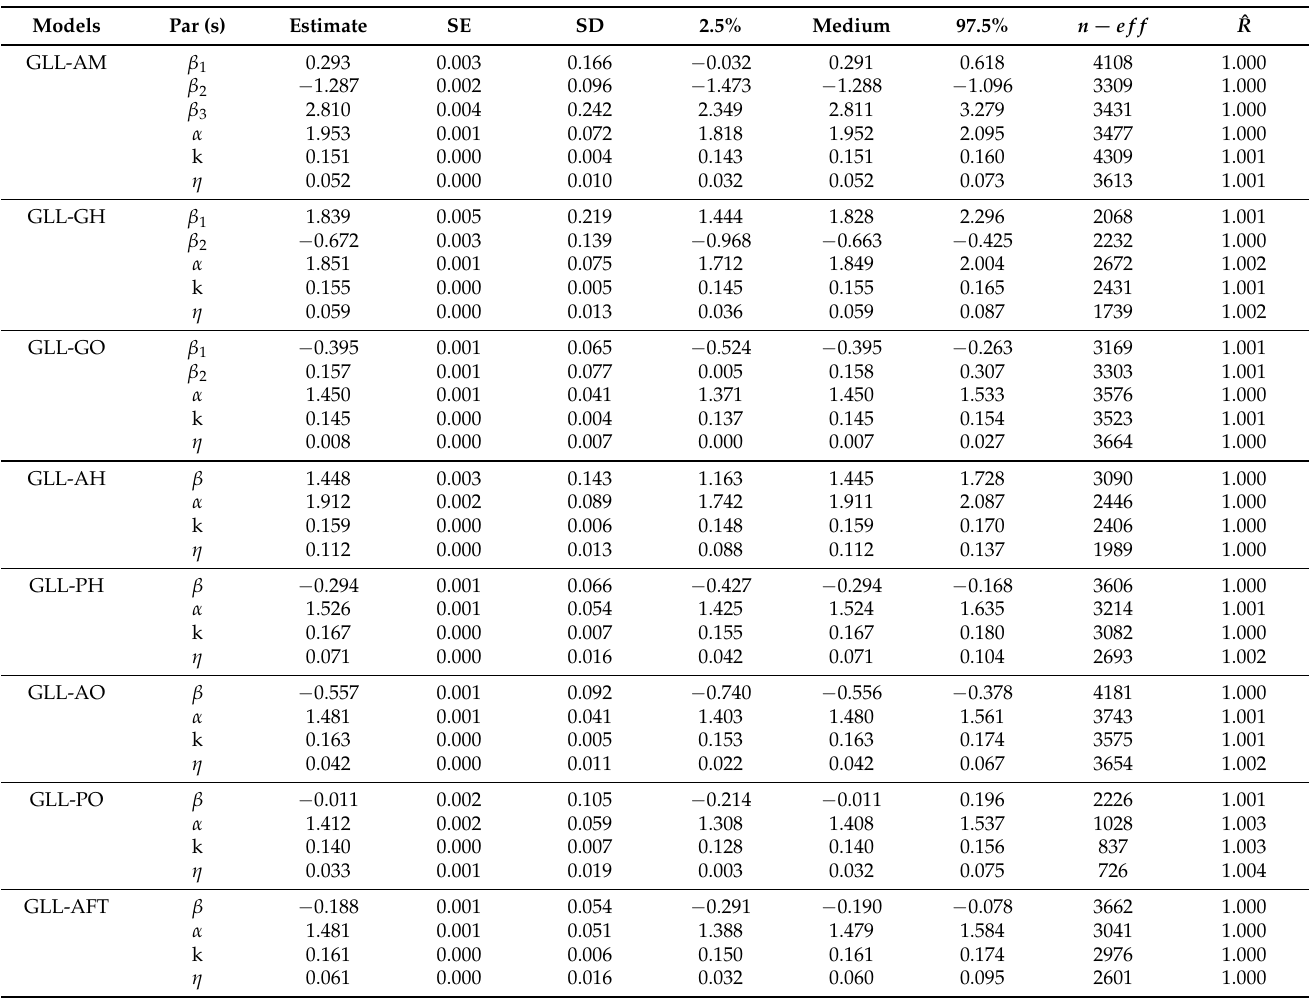
Table 8. Results for the posterior properties of the competitive models.